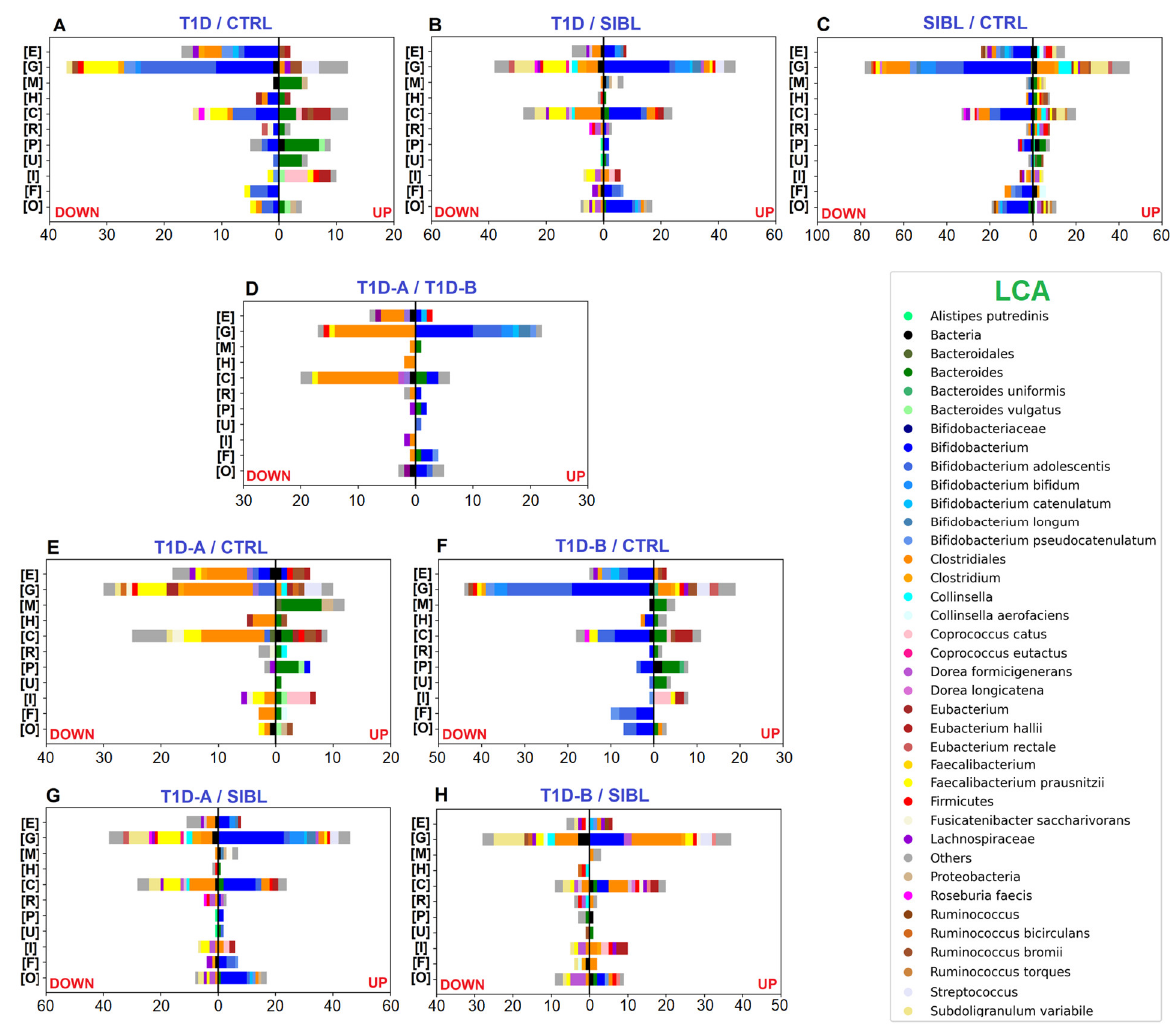
Figure 2. Bar charts plotting the number of statistically significant differential PGs, determined by the abundance ratio values in the comparison between groups of individuals and associated with functional annotation. Color code identifies taxa assigned to UP- (right) and DOWN-regulated (left) PGs by LCA. Selected COG categories: [C] Energy production and conversion—[E] Amino acid transport and metabolism—[F] Nucleotide transport and metabolism—[G] Carbohydrate transport and metabolism—[H] Coenzyme transport and metabolism—[I] Lipid transport and metabolism— [M] Cell wall/membrane/envelope biogenesis—[O] Posttranslational modification, protein turnover, chaperones—[P] Inorganic ion transport and metabolism—[R] General function prediction only—[U] Intracellular trafficking,secretion, and vesicular transport. Panels ( A – C ): comparisons between T1D, CTRL, and SIBL groups. Panel ( D ): comparison between groups of patients stratified by severity (T1D-A and T1D-B). Panels ( E , F ): tests comparing T1D-A and T1D-B groups versus CTRL. Panels ( G , H ): tests comparing T1D-A and T1D-B groups versus